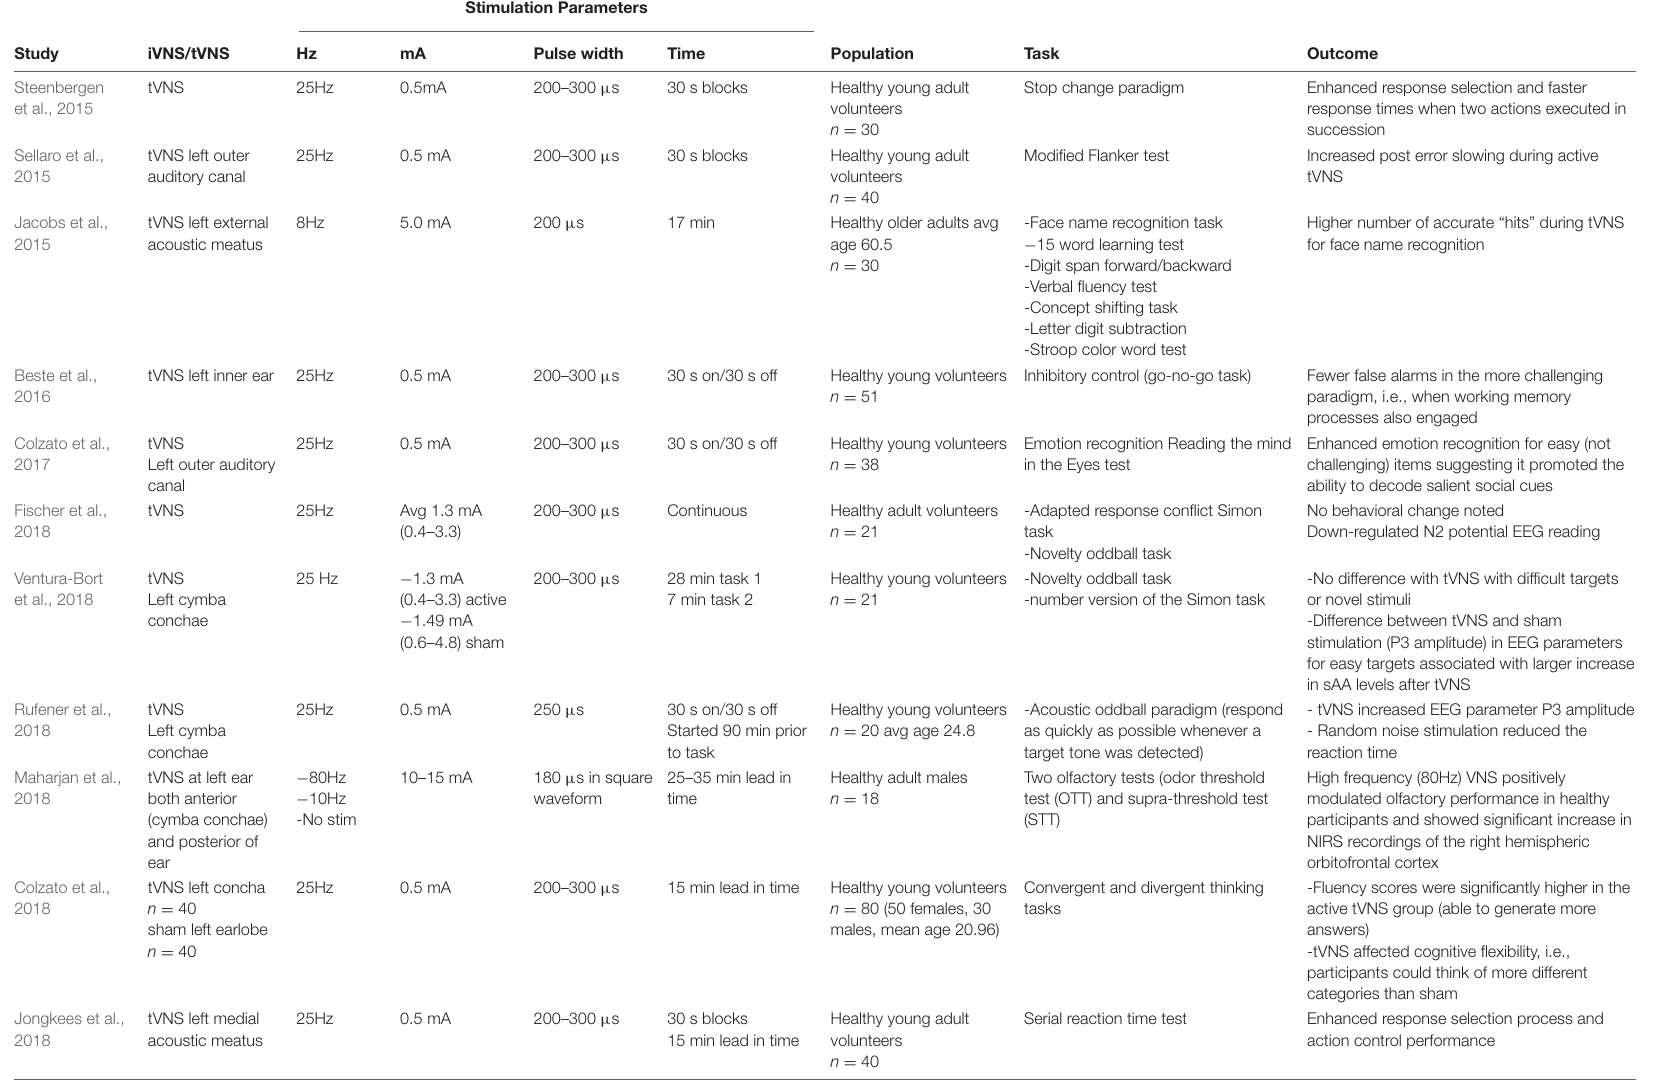
TABLE 2 | Cognition and VNS in healthy volunteer